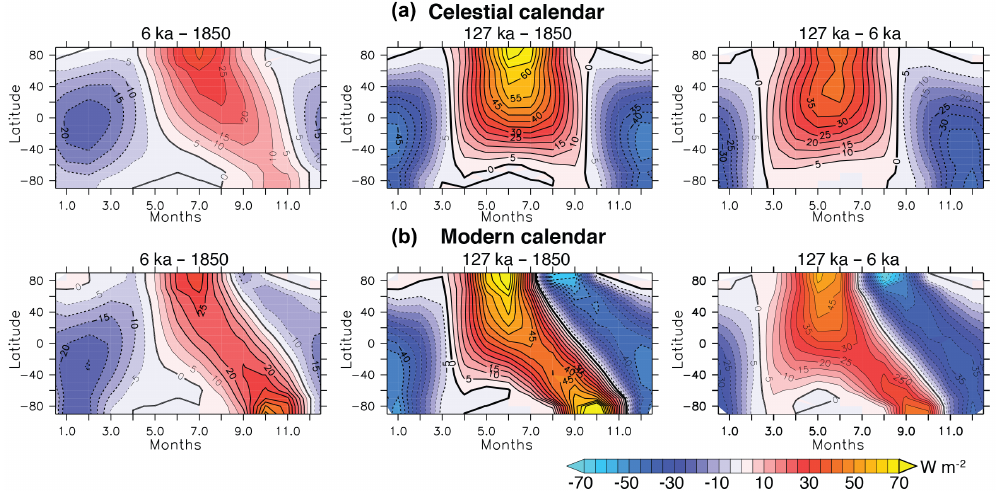
Figure 3. Latitude–month insolation anomalies (6ka–1850, 127ka–1850, 127–6ka) computed using either the celestial calendar (a) or the modern calendar (b) , with vernal equinox on 21 March at noon, to compute monthly averages (Wm − 2 ) .